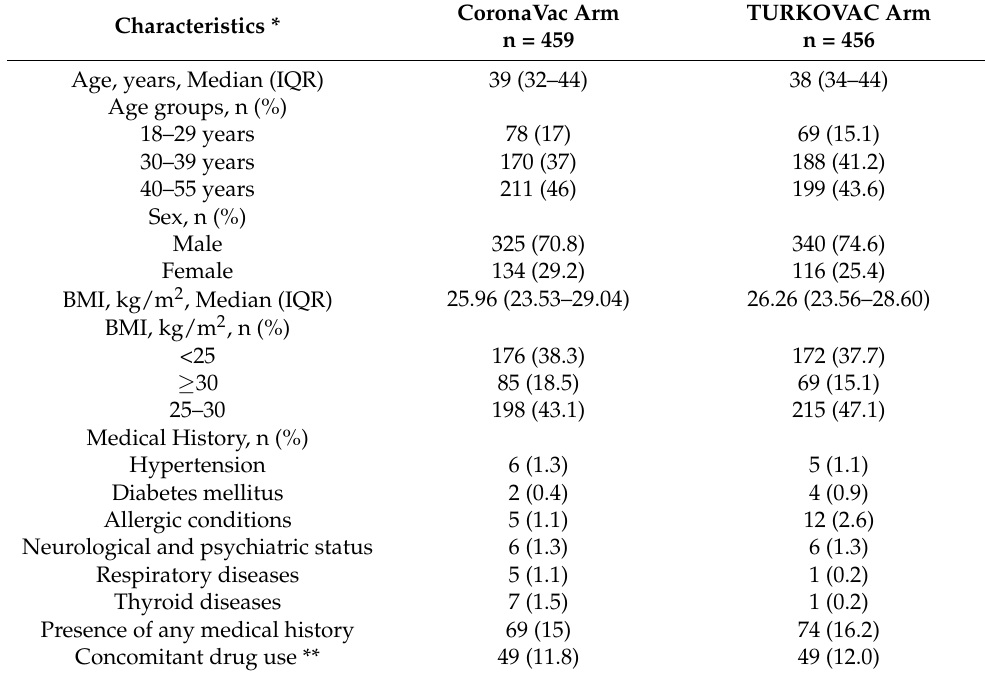
Table 1. Main characteristics of the study